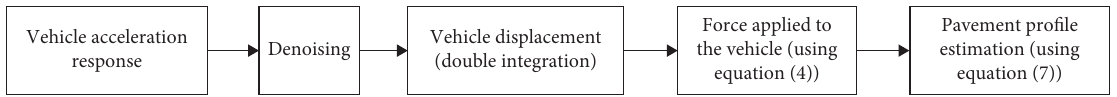
Figure 2: Flowchart of the proposed SMND approach for pavement profile